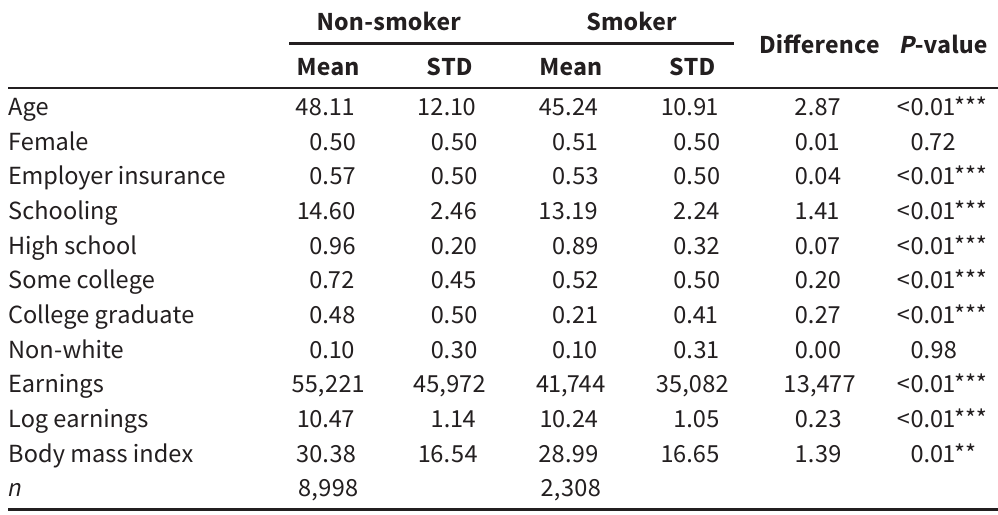
Are smokers different than nonsmokers?